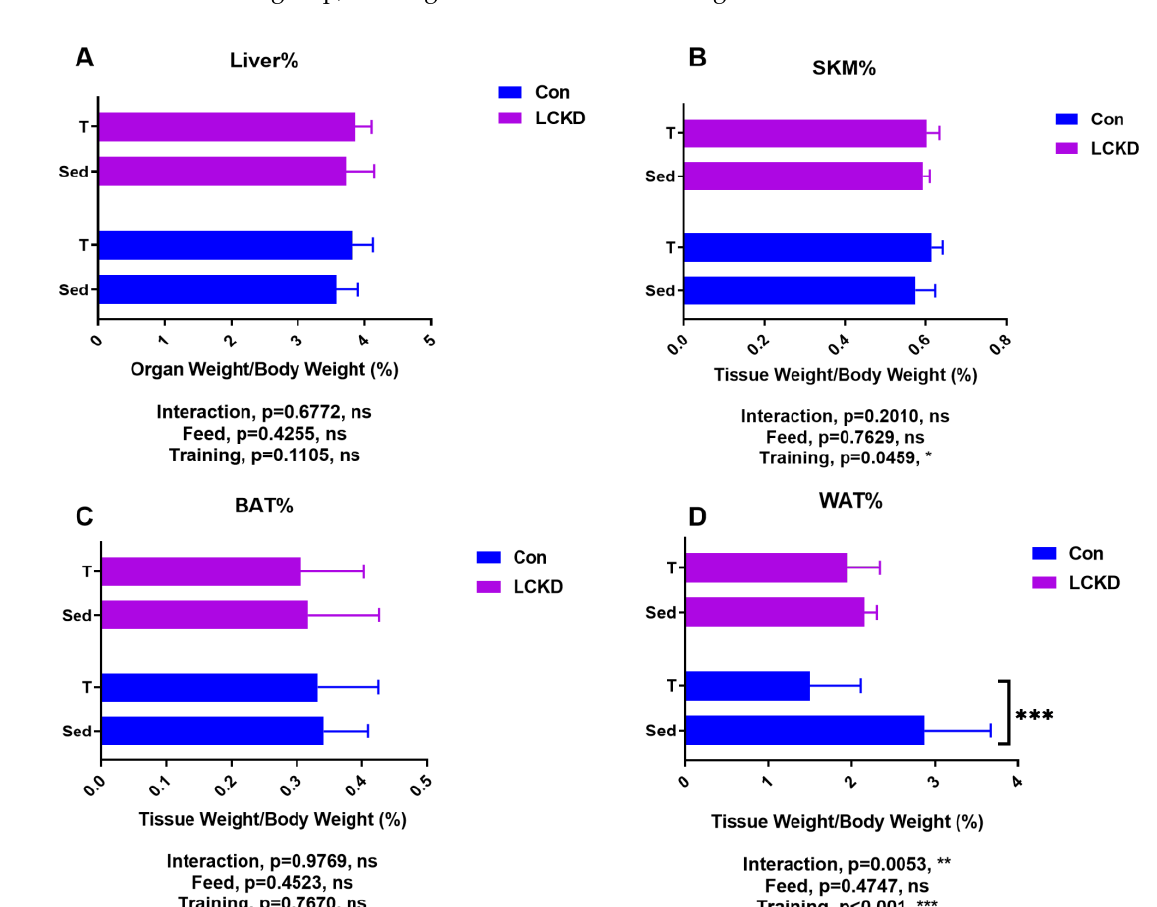
Figure 2. Tissues and organ weight/body weight ratio changes. ( A ) Relative ratio between whole liver and body weight; ( B ) relative ratio between skeletal muscle and body weight; ( C ) relative ratio between brown adipose tissue and body weight; ( D ) relative ratio between epididymal adipose tissue and body weight. SKM, skeletal muscle; WAT, white adipose tissue, epididymal adipose tissue; BAT, brown adipose tissue. % signifies the ratio between the indicated organ or tissue